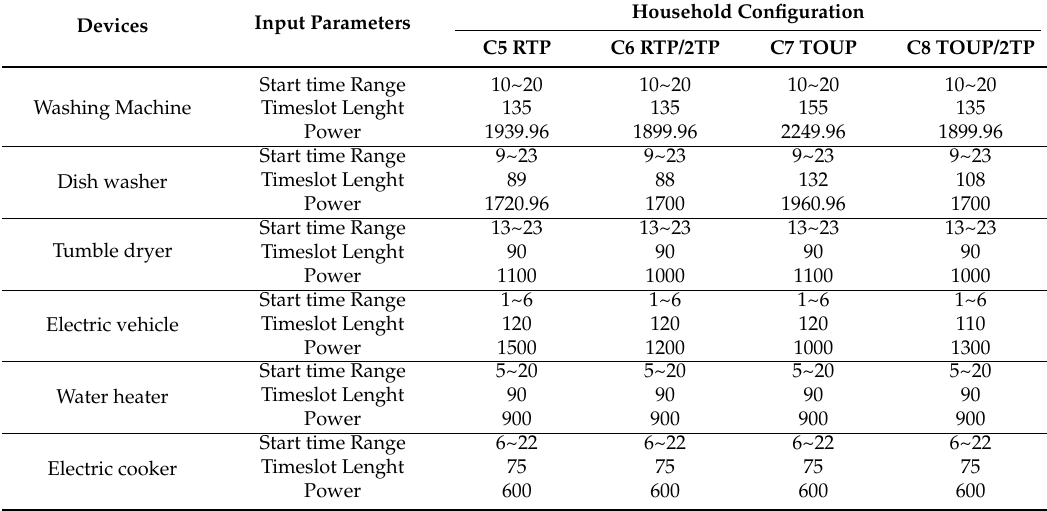
Table A2. Configuration for six appliance scheduling with dynamic pricing